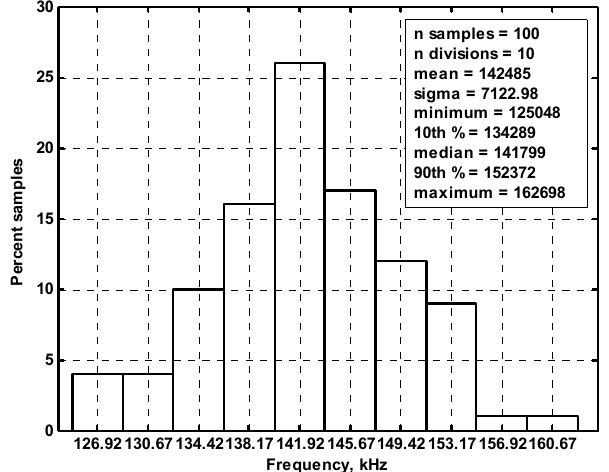
Figure 23. Histogram of the Monte-Carlo analysis for the BP filter.